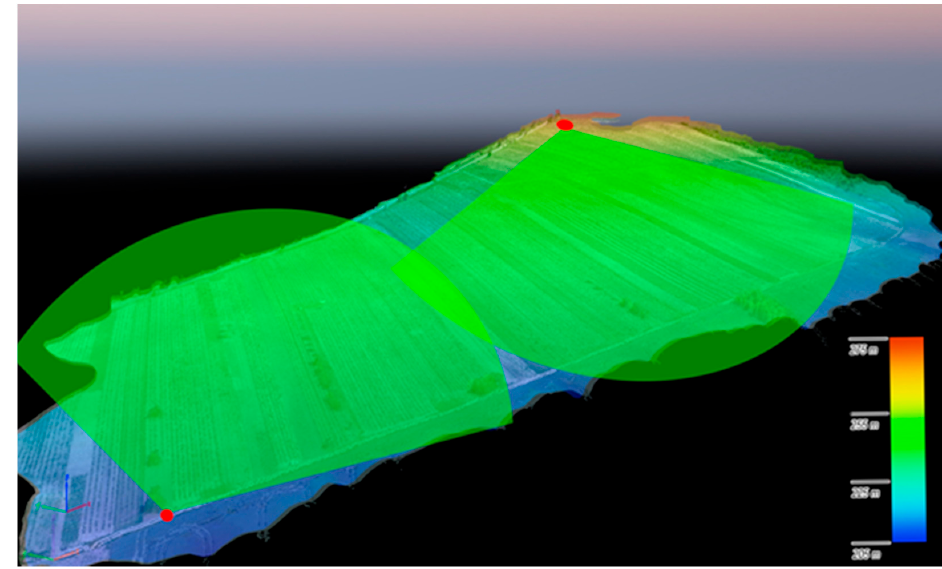
Figure 7. A special content 3D map: the placement of the optical detectors.